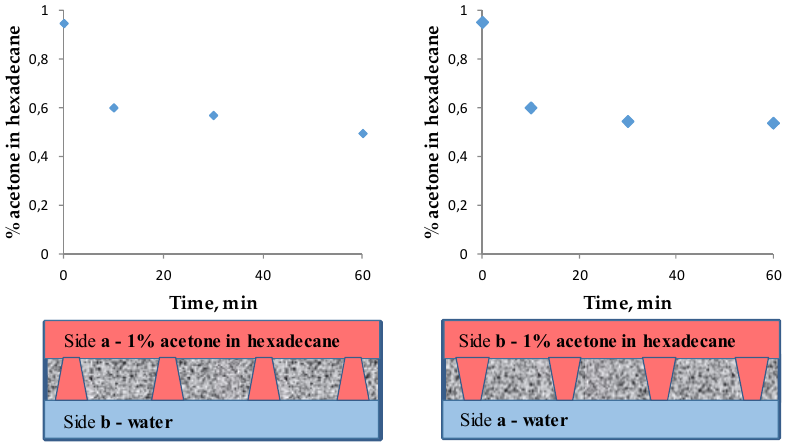
Figure 10. Decrease in the acetone content in the organic phase in the liquid–liquid membrane contactor with different membrane arrangements.